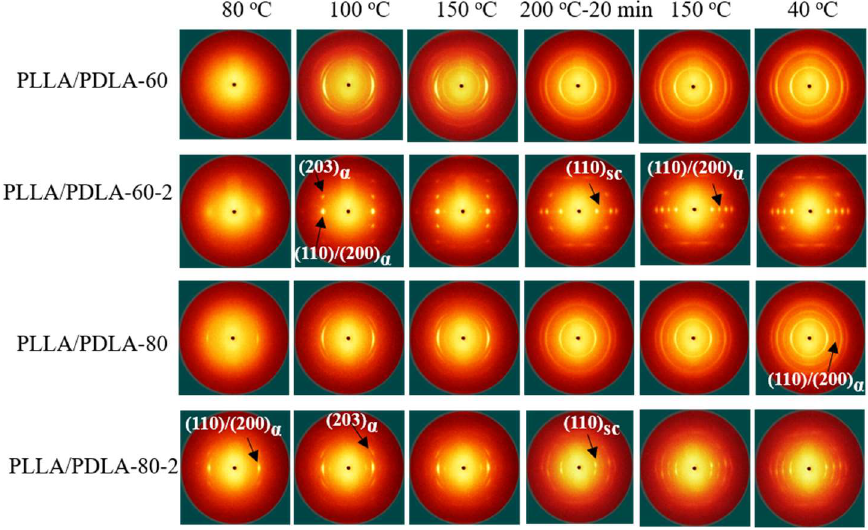
Figure 3. Selected 2D WAXS patterns of PLLA/PDLA fibers during heating and cooling. The stretching direction was vertical.